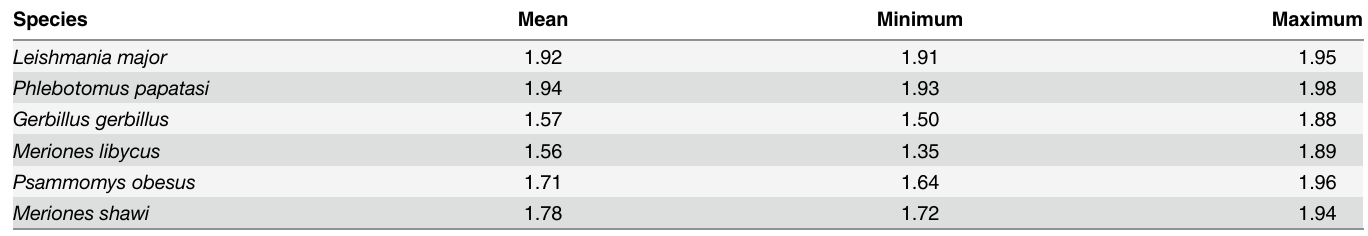
Table 1. Results of partial ROC analysis to test statistical significance of ecological niche model predictions. A value of 1.0 is equivalent to the per- formance of a random classifier. These results were based on 100 bootstrap replicates, and statistical significance was assessed via bootstrapping and com- parison with a random classifier ratio of